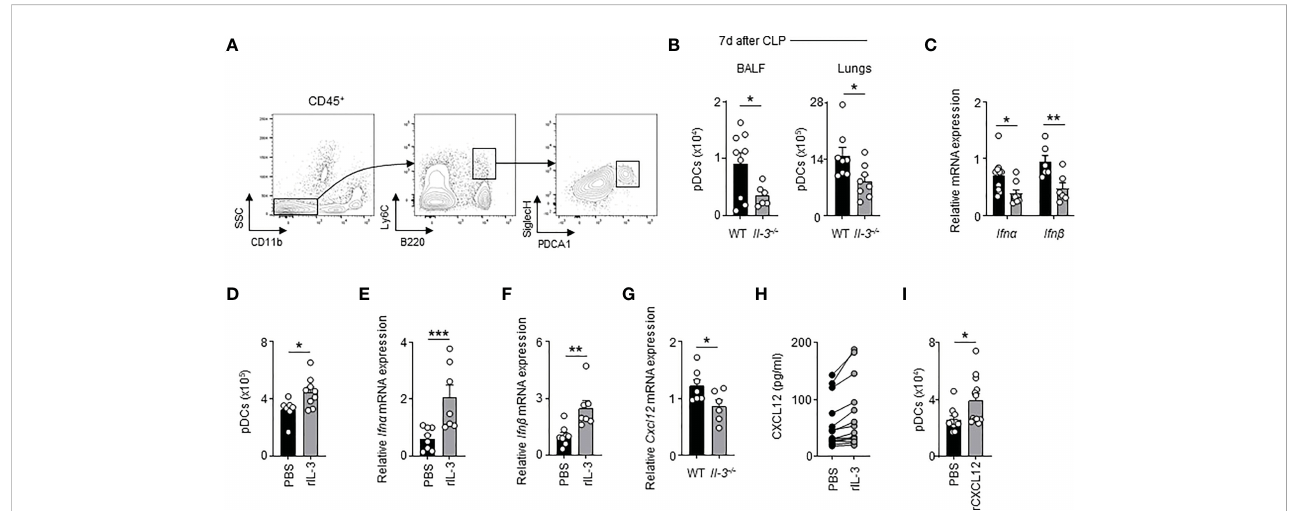
FIGURE 3 Interleukin-3 promotes the recruitment of pDC in lungs of CLP mice during viral pneumonia. (A) Gating strategy for murine pDCs in lungs. (B) Absolute number of pDCs in the BALF and lungs of CLP WT or Il-3 -/- mice 3 days after HSV-1 infection (n=8-9). (C) Relative mRNA expression of Ifn a and Ifn b in lungs of CLP WT or Il-3 -/- mice 3 days after HSV-1 infection (n=6-10). (D) Absolute number of pDCs in the lungs of CLP WT mice 24h after i.n. injection of PBS or recombinant IL-3 (n=7-9). (E, F) Relative mRNA expression of Ifn a (E) and Ifn b (F) in the lungs of CLP WT mice 24h after i.n. injection of PBS or recombinant IL-3 (n=7-8). (G) Relative mRNA expression of Cxcl12 in the lungs of CLP WT or Il-3 -/- mice 3 days after HSV-1 infection (n=6-7). (H) Levels of CXCL12 in the supernatant of lung cells from CLP mice 24 h after ex vivo stimulation with or without IL-3 (n=14). (I) Absolute number of pDCs in the lungs of CLP WT mice 24h after i.n. injection of PBS or recombinant CXCL12 (n=10-12). Data are mean ± s.e.m., *P < 0.05, **P < 0.01, ***P < 0.001, unpaired or paired 2-tailed Student ’ s t test using Welch ’ s correction for unequal variances was